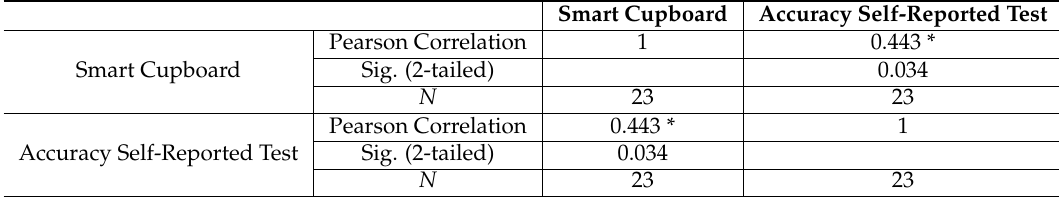
Table 6. Correlation between the accuracy of SC and that of self-reported tests. Smart Cupboard Accuracy Self-Reported Test Pearson Correlation 1 0.443 * Smart Cupboard Sig. (2-tailed) 0.034 N 23 Pearson Correlation 0.443 * Accuracy Self-Reported Test 0.034 23 23 *. Correlation is significant at the 0.05 level